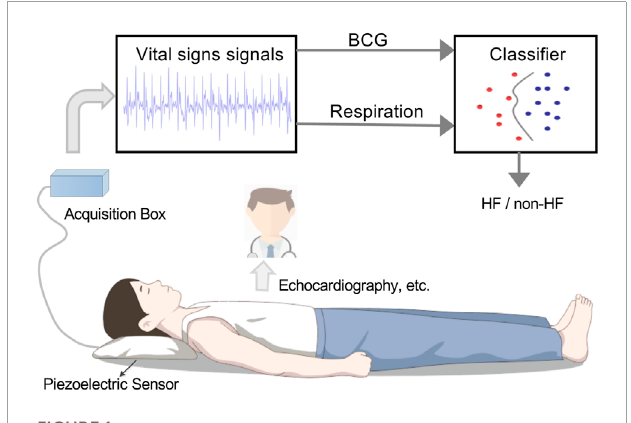
FIGURE 1 Heart failure detection by using non-contact recorded vital